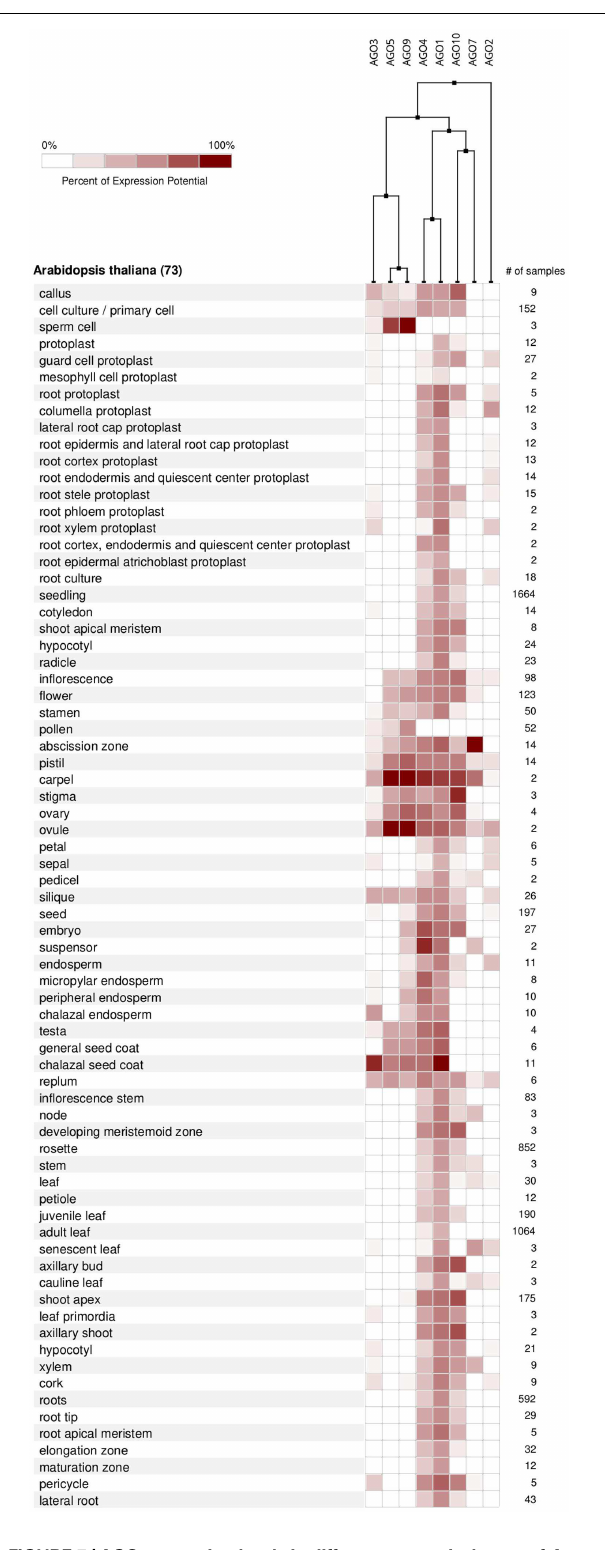
FIGURE 7 |AGO expression levels in different anatomical parts of A. thaliana based on microarray data from Genevestigator and associated hierarchical